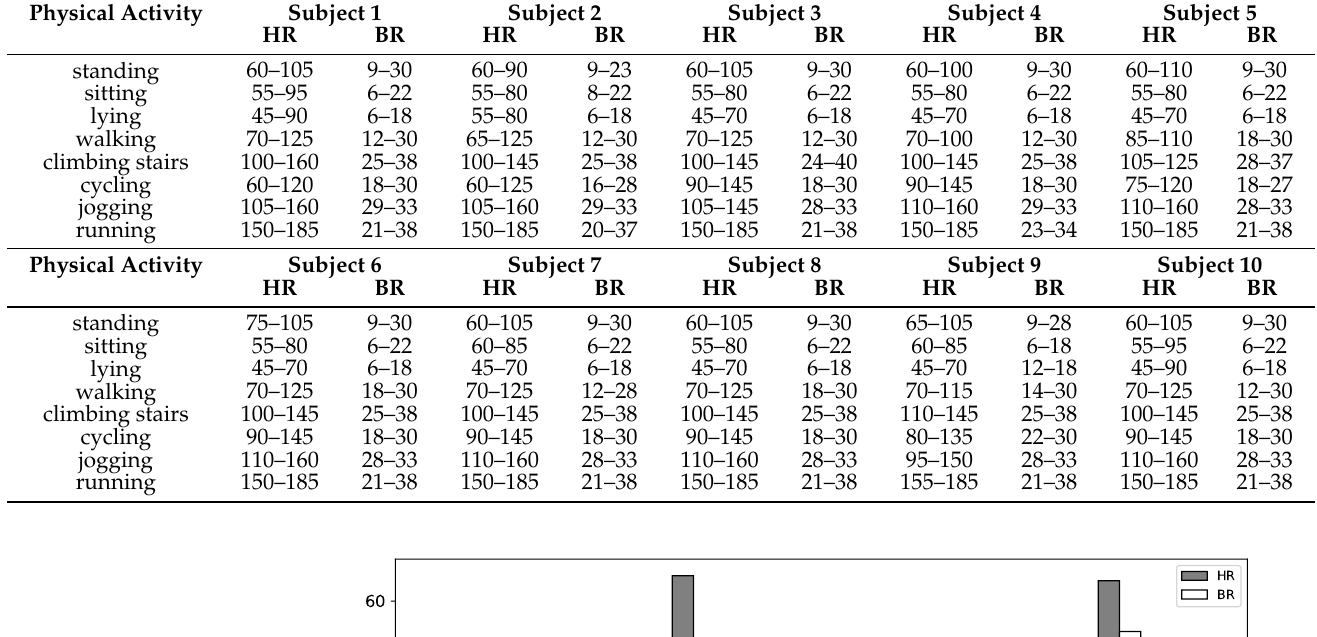
Table 6. Vital signs’ green zone ranges during physical activities for each monitored subject.